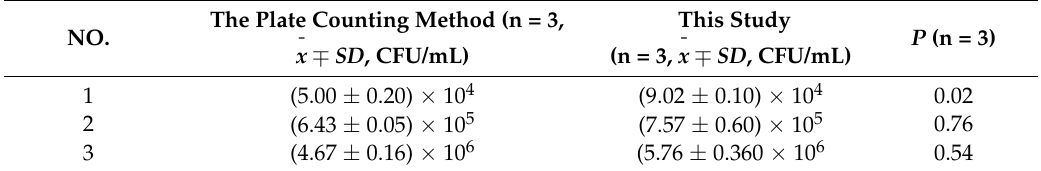
Table 2. Comparison between the proposed method and the plate counting method for detection of E. coli at 95% confidence